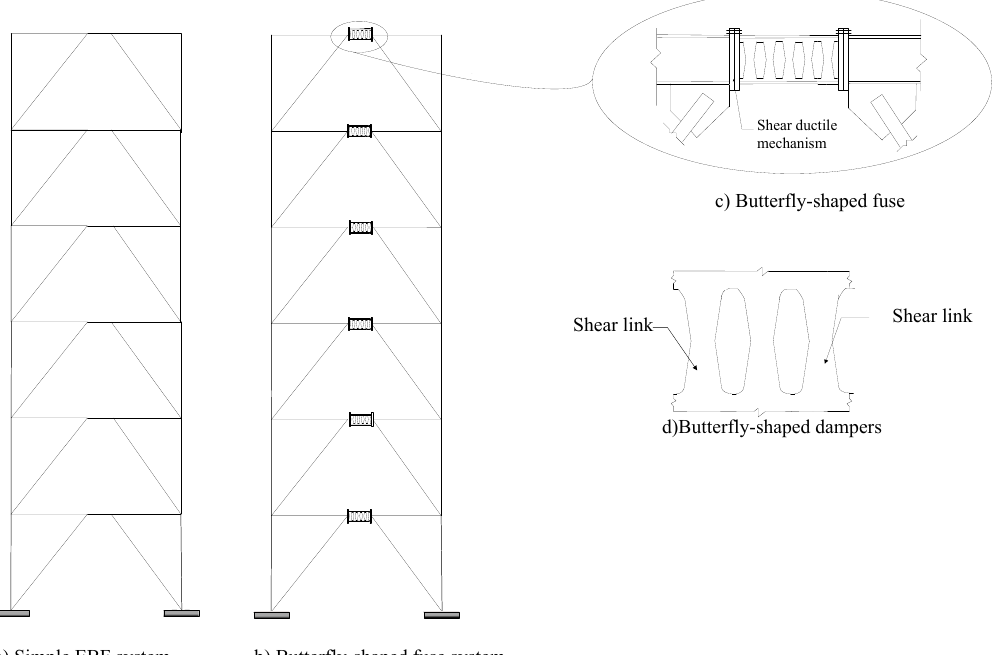
Figure 4. Schematic representation of a six-story building with and without butterfly-shaped fuses for IDA analysis. ( a ) Simple EBF system; ( b ) Butterfly-shaped fuse system; ( c ) Butterfly-shaped fuse; ( d ) Butterfly-shaped dampers. Table 1. Shear forces used for designing butterfly-shaped shear fuses.